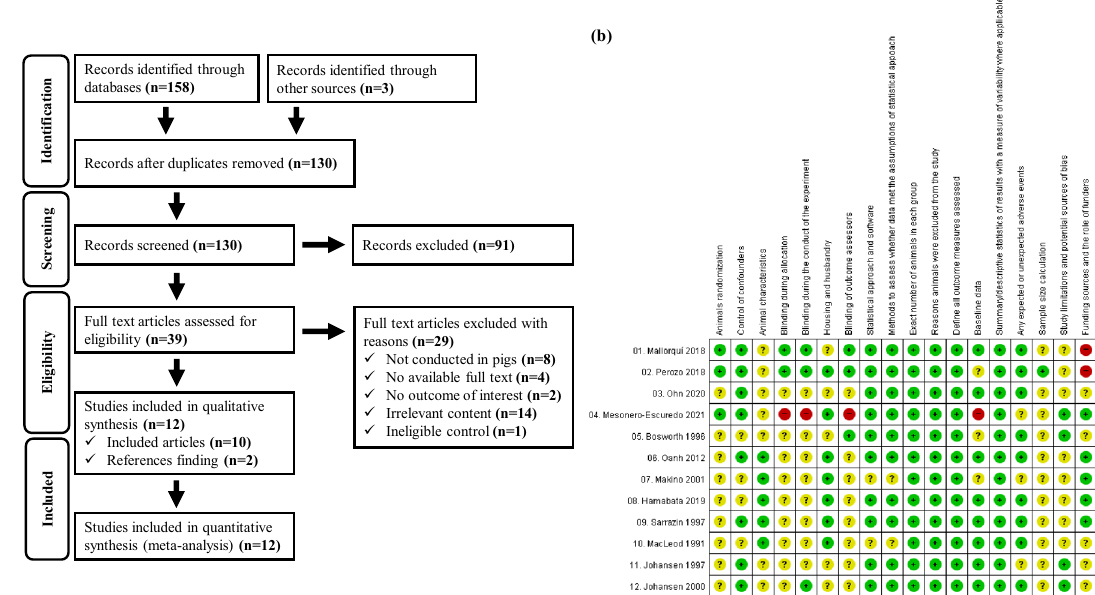
Figure 1. ( a ) PRISMA-P flowchart and ( b ) risk of bias assessment of eligible studies on vaccination against edema disease in